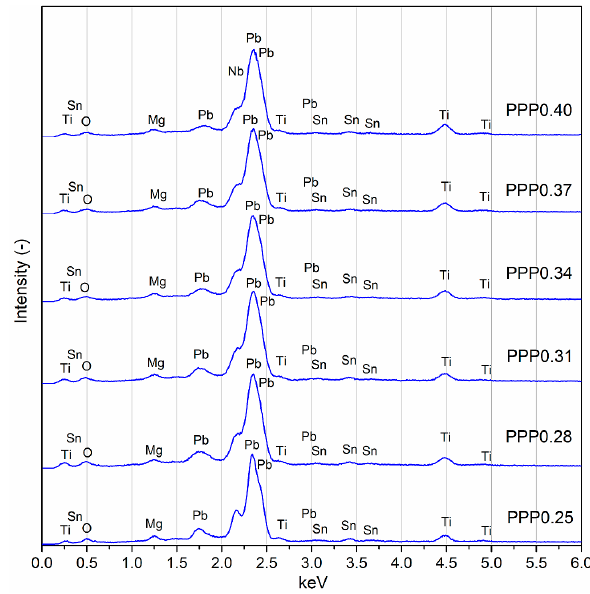
Figure 3. Energy dispersive spectrometry (EDS) tests of the PMN–PT–PS solid solutions.